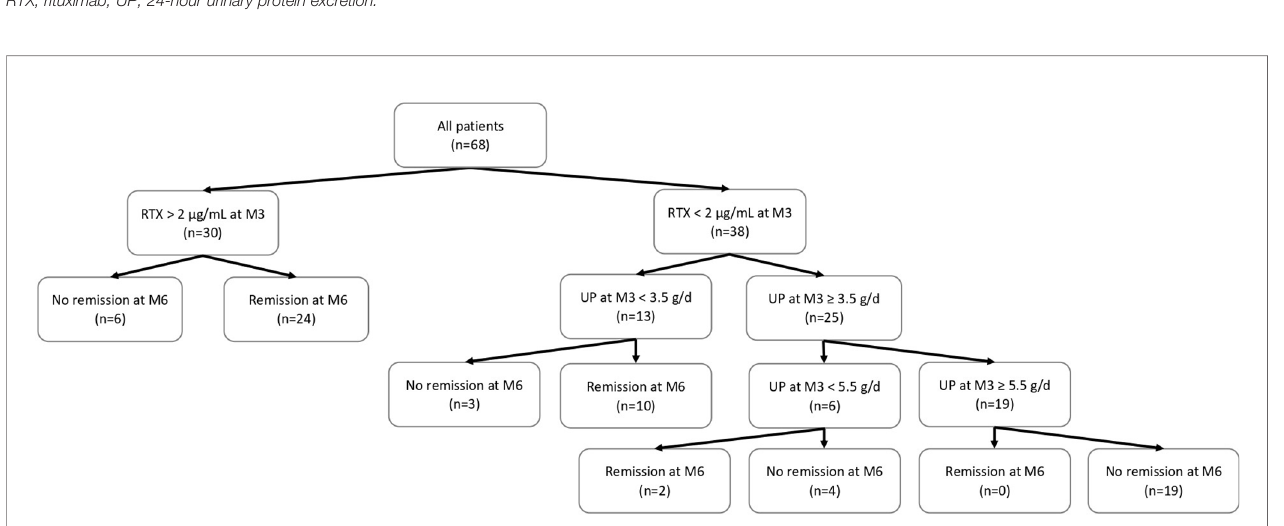
FIGURE 2 | Flow chart of patients included inthis study and outcome according to serum rituximab levels at month-3. M3, month-3 after rituximabinjection; M6, month-6 after rituximabinjection; RTX, rituximab; UP, 24-hour urinary protein excretion.